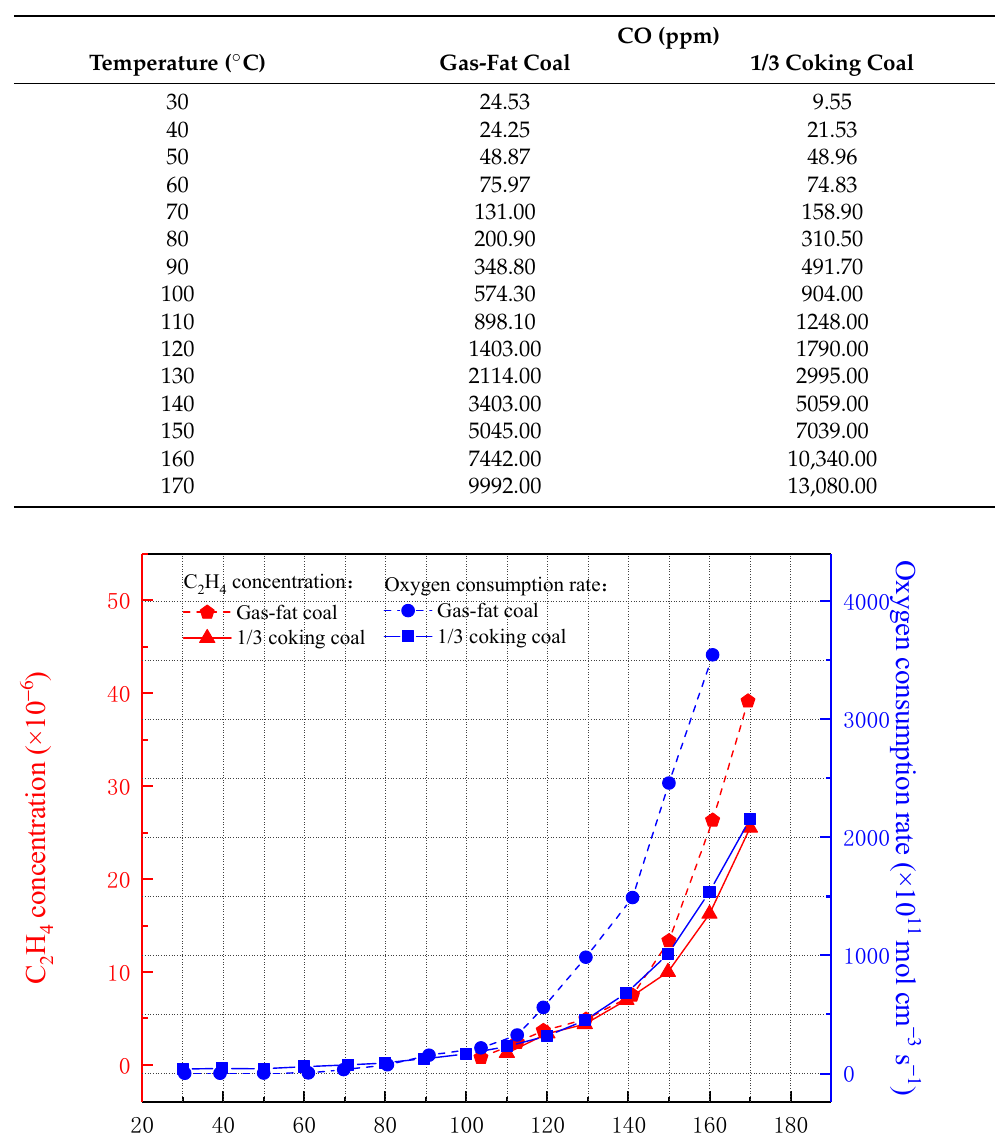
Table 1. CO concentration versus temperature.